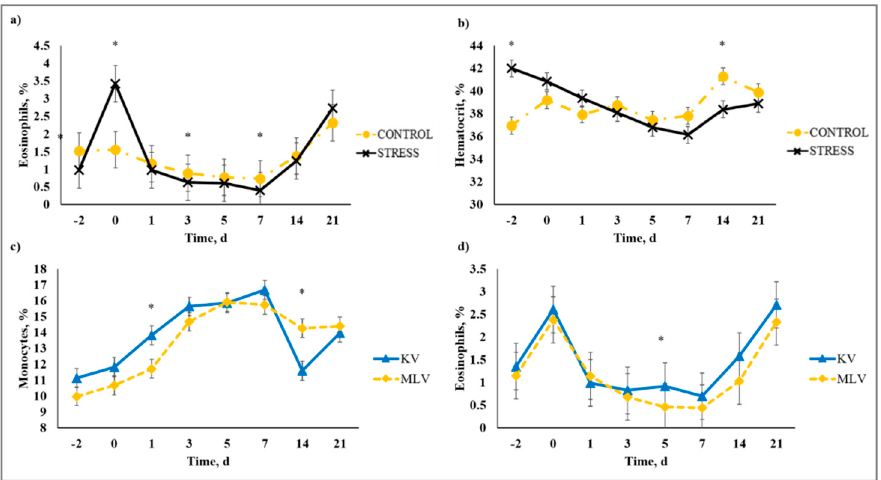
Figure 8. Effect of non-stress control (C; weaned on Day − 37; transported to West Texas A&M University research facility on Day − 21; vaccination on Day 0) and stress model implementation (S: weaned on Day − 3; transported to USDA-ARS Livestock Issues Research Unit on Day − 2; relocated to WTAMU on Day − 1; vaccination on Day 0) on: ( a ) percent eosinophils (PEREOS); and ( b ) hematocrit (HCT). Effect of stress model on PEREOS (stress model × day effect; p < 0.01); HCT (stress model × day effect; p < 0.01) and effect of killed virus (KV; Triangle 5; Boehringer Ingelheim Animal Health, Inc. (BIAH)) and modified-live virus vaccination (MLV; Pyramid 5; BIAH) treatment on: ( c ) percent monocytes (PERMONO); and ( d ) percent eosinophils (PEREOS) after subcutaneous injection of multivalent respiratory vaccine on day 0. Effect of vaccination on PERMONO (vaccine treatment × day effect; p < 0.01); PEREOS (vaccine treatment × day effect; p < 0.01). * C differs from S within day, p ≤ 0.02; * KV differs from MLV within day, p ≤ 0.02.